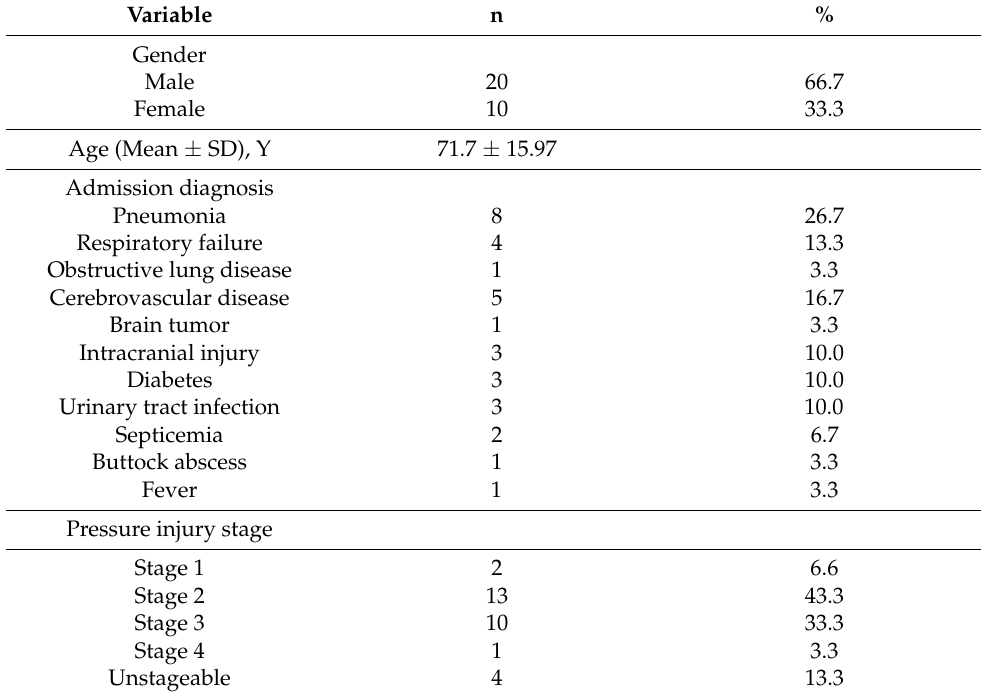
Table 1. Demographic characteristics of the cases (N =